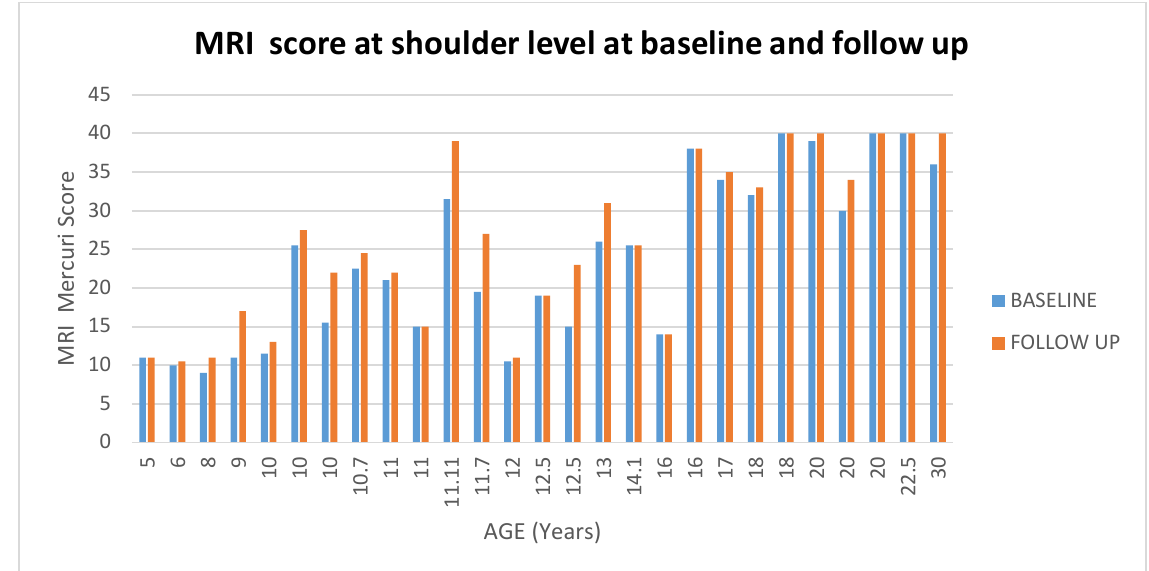
Figure 4. showed scores in muscle MRI at shoulder level at baseline and at follow up according to the age.